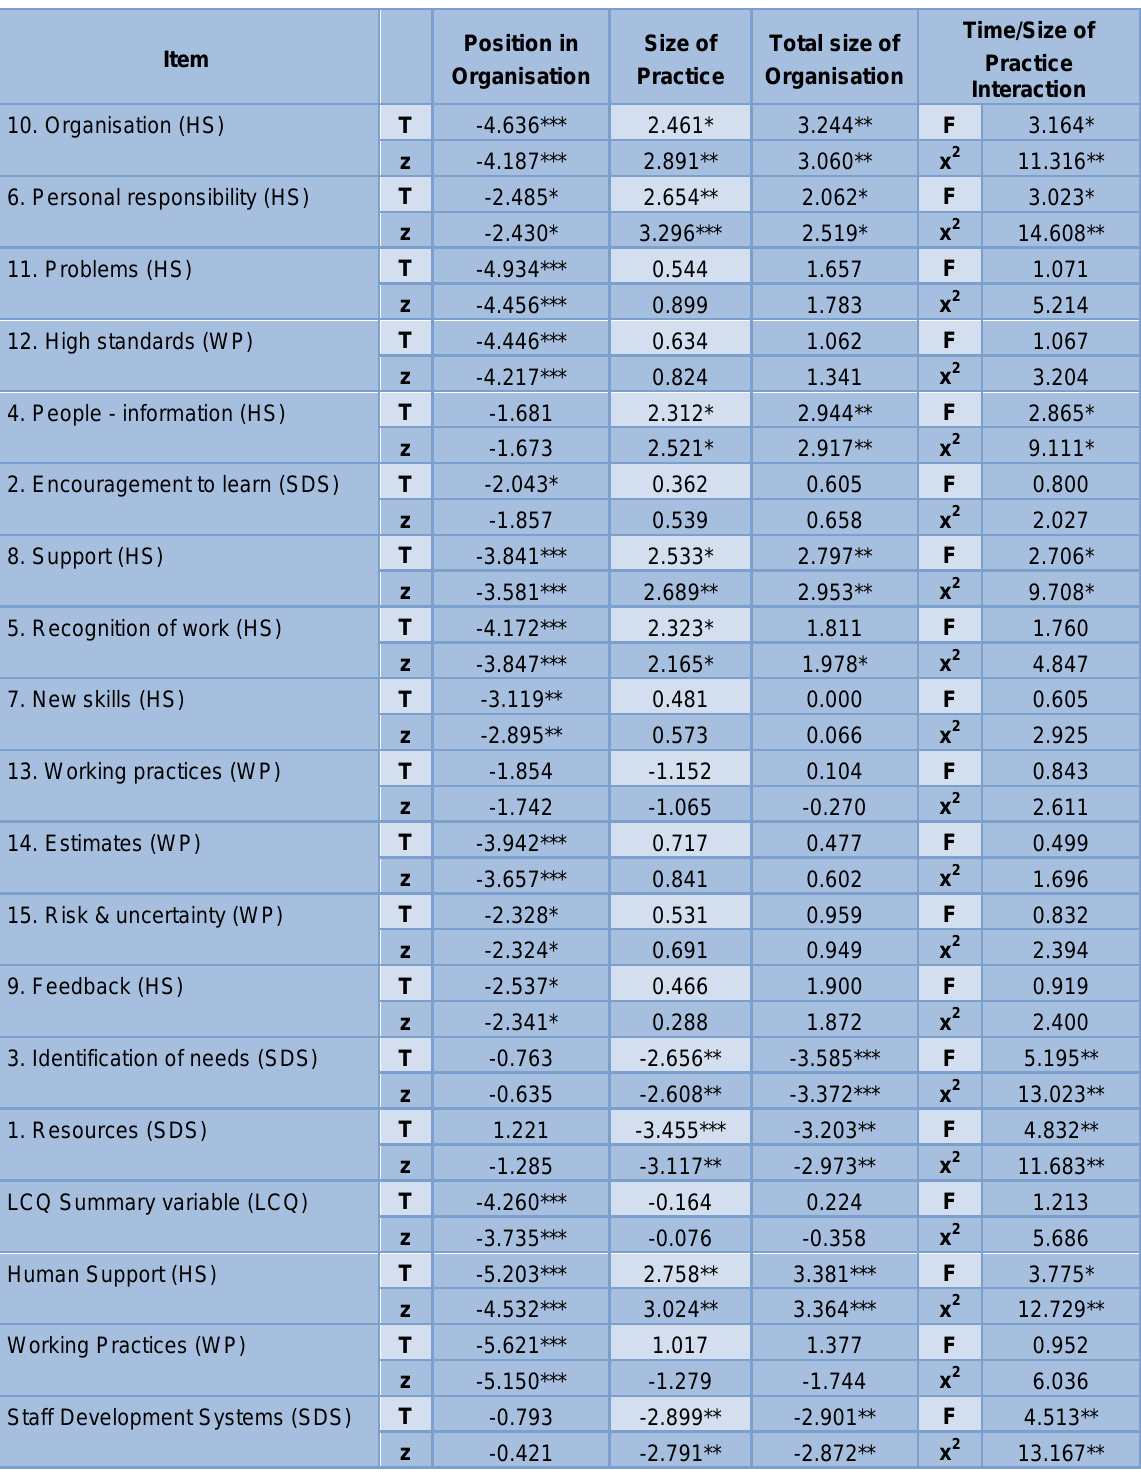
Table 2 ANOVA and tests for differences for Learning Climate Questions (n =